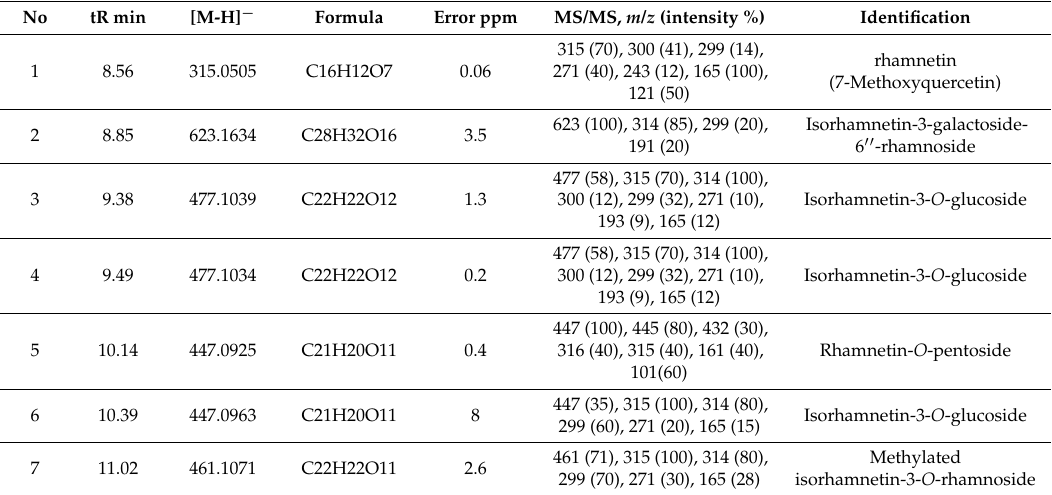
Putative identification of peaks significantly accumulated in Kanza leaves using UHPLC–MS/MS in negative electrospray ionization mode. The MS/MS spectra were acquired using a ramped collision energy from 10 to 60 eV. The identifications were based on MS/MS spectral data and spectral library